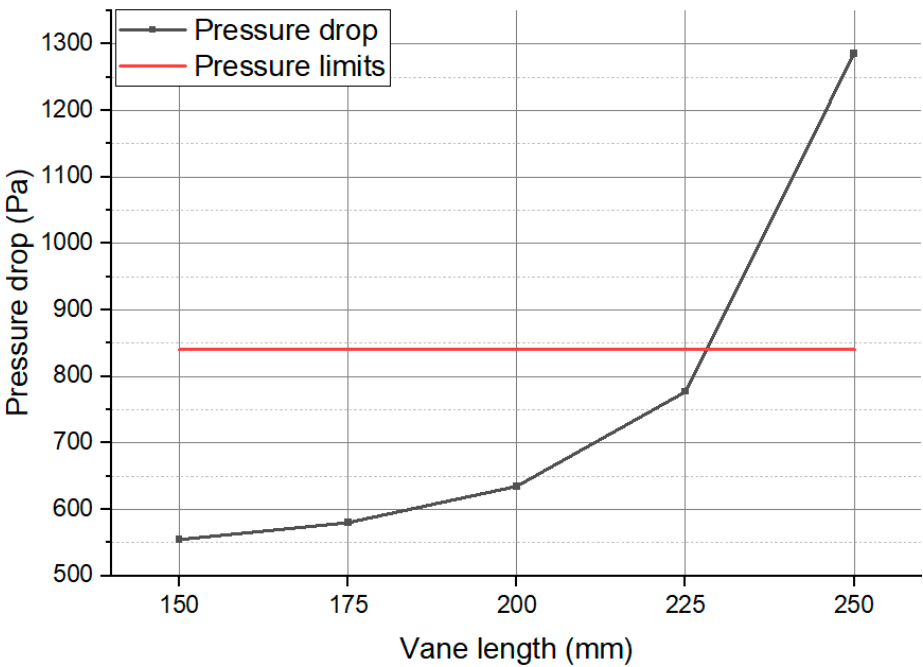
Figure 23. Pressure drop graph according to the vane length in the outer vane reverse type.